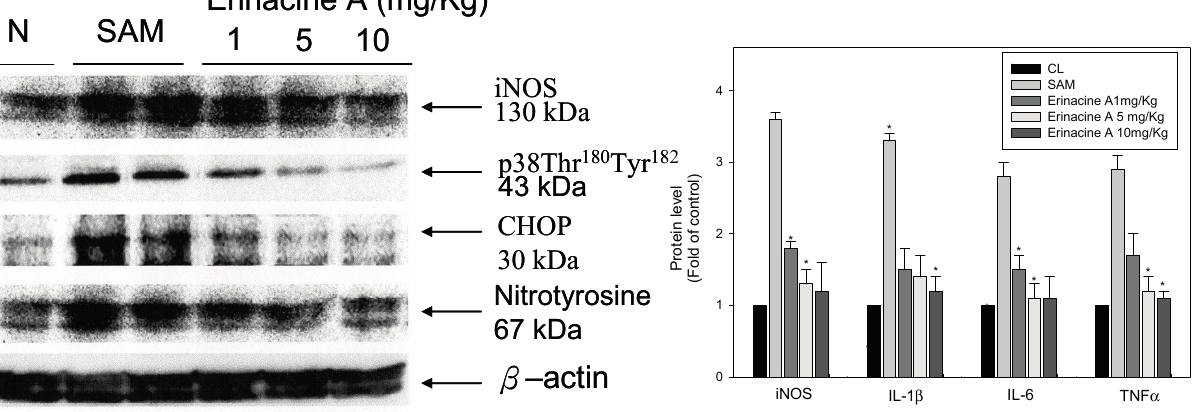
Figure 6. Western blot analysis of iNOS, p38 MAPK and CHOP immunoreactivity after transient global ischemia. Western blot analysis of iNOS, phosphorylation of p38 MAPK, CHOP and nitrotyrosine protein expression in transient stroke as seen in animal model rats. Mice were treated with (control group, CL) or without erinacine A. Representative brain 10 mg/kg). Equal amounts of protein from total cell lysates of the rat brain treated with against iNOS, p38 MAPK, CHOP, and nitrotyrosine. â-Actin served as the internal control. Protein levels were quantified by densitometric analysis with the control being set at